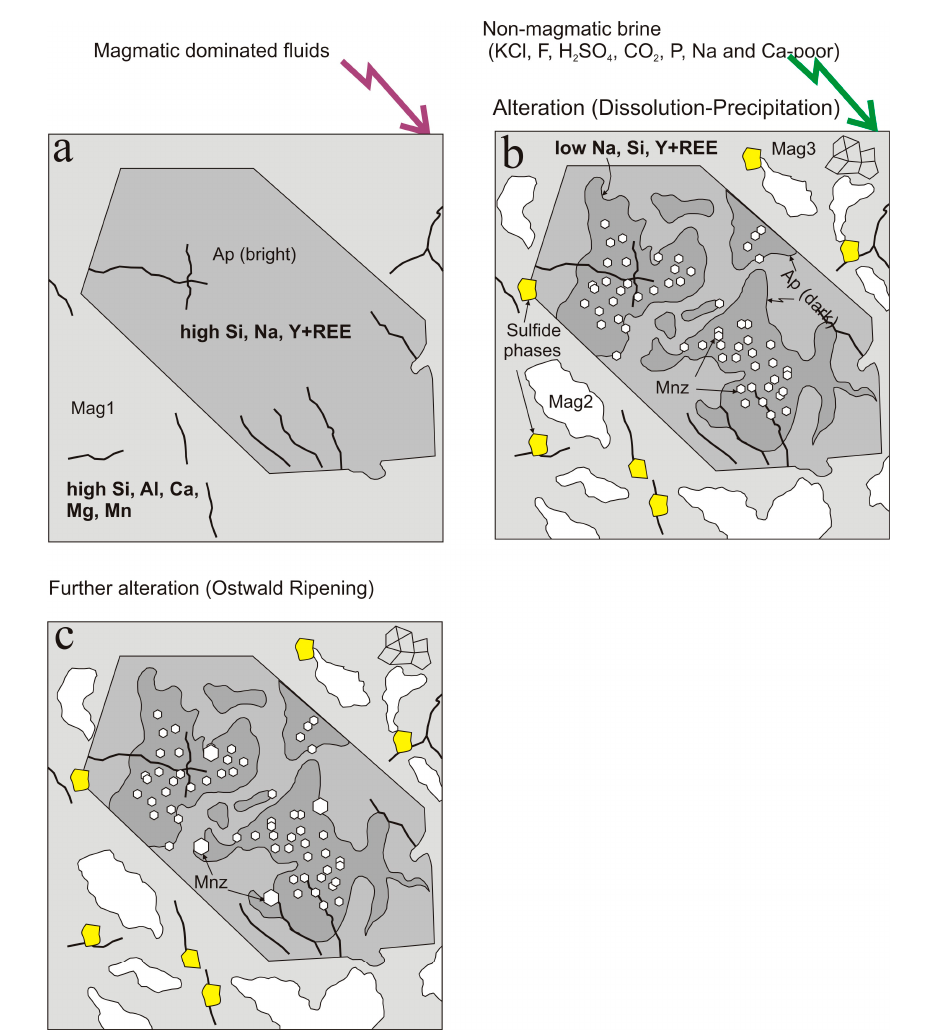
Figure 16. Schematic illustration for the mineralization and alteration history in the Chadormalu deposit. ( a ) Mineralization of the primary high Si magnetite (Mag 1) and REE-rich apatites (Ap, bright areas) from a magmatic dominated fluid at 490 ± 21 Ma; ( b ) Contribution of non-magmatic fluids enriched in KCl, F, H 2 SO 4 , CO 2 , and P, which are Na- and Ca-deficient, in alteration process and related dissolution-reprecipitation stage, in the formation of secondary magnetite (Mag2). These fluids also interacted with the primary bright apatites, leading to remobilization and developing of Si-, Na-, and Y + REE-depleted dark areas in the apatites, as well as formation of monazite and rarely allanite crystals due to dissolution-reprecipitation process. This reaction stage probably occurred at 437 ± 12 Ma; ( c ) Further alteration caused growth of fine monazite inclusions. The maximum age of 490 ± 21 Ma calculated for BSE- bright apatite in this study overlaps, within error, the lower end of previous age estimates for primary apatite in the Bafq district. On the other hand, the maximum age of 437 ± 12 Ma obtained from BSE-dark apatite provides an important evidence of a later process that led to development of dark domains and monazite inclusions; this appears to have occurred synchronous with the overprint potassic alteration in Chadormalu altered host rocks. This event was consistent with a regional extension and associated basin development and magmatism in Silurian, the evidence for which is provided by syenite intrusions and alkali basalts in Central Iran [85].